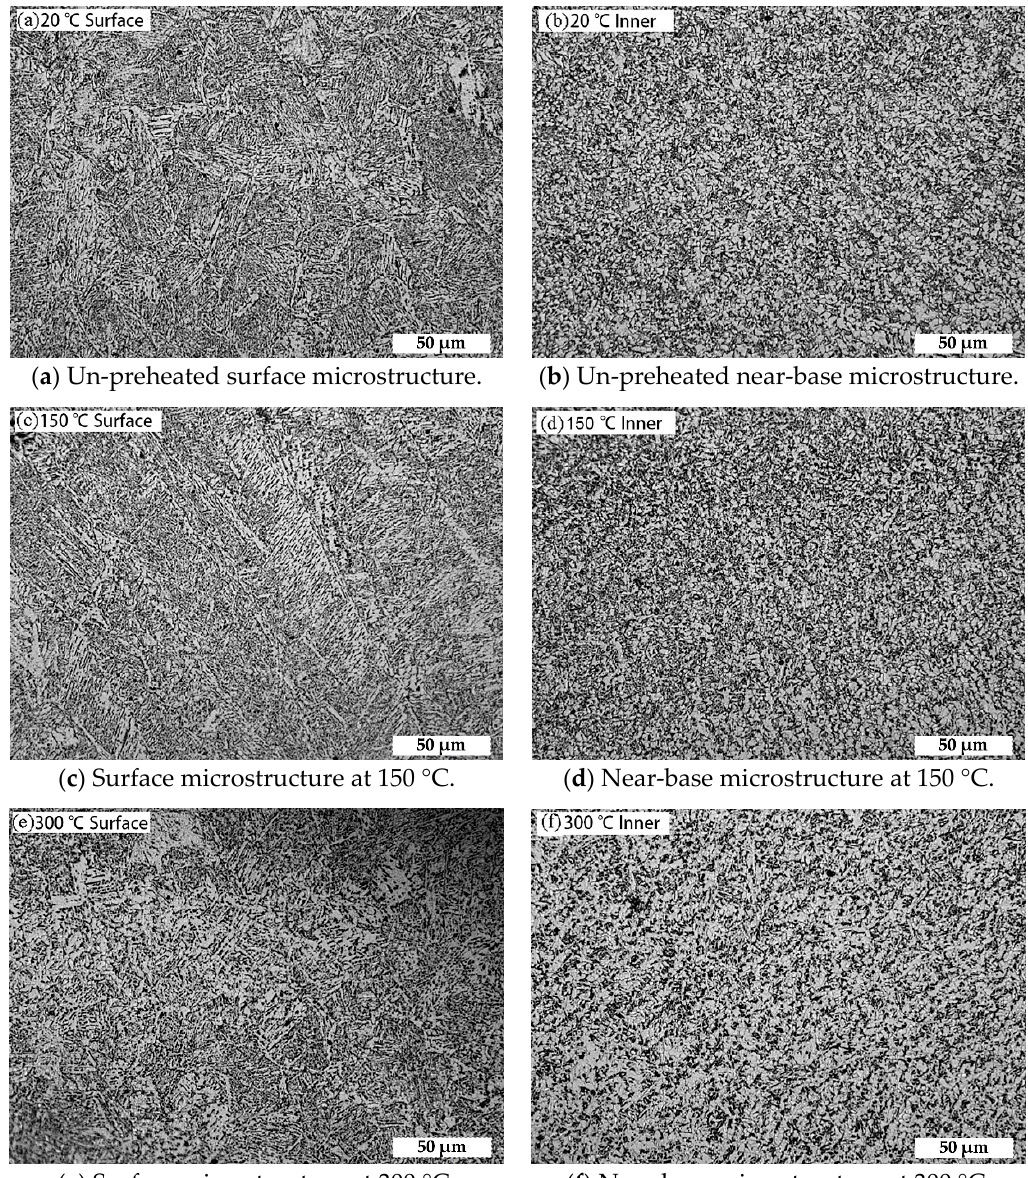
Figure 2. Microstructure at different preheating temperatures.